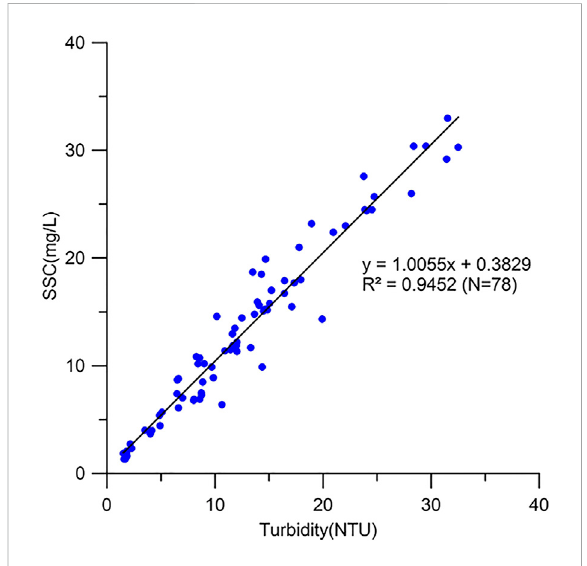
FIGURE 2 The relationship between SSC and